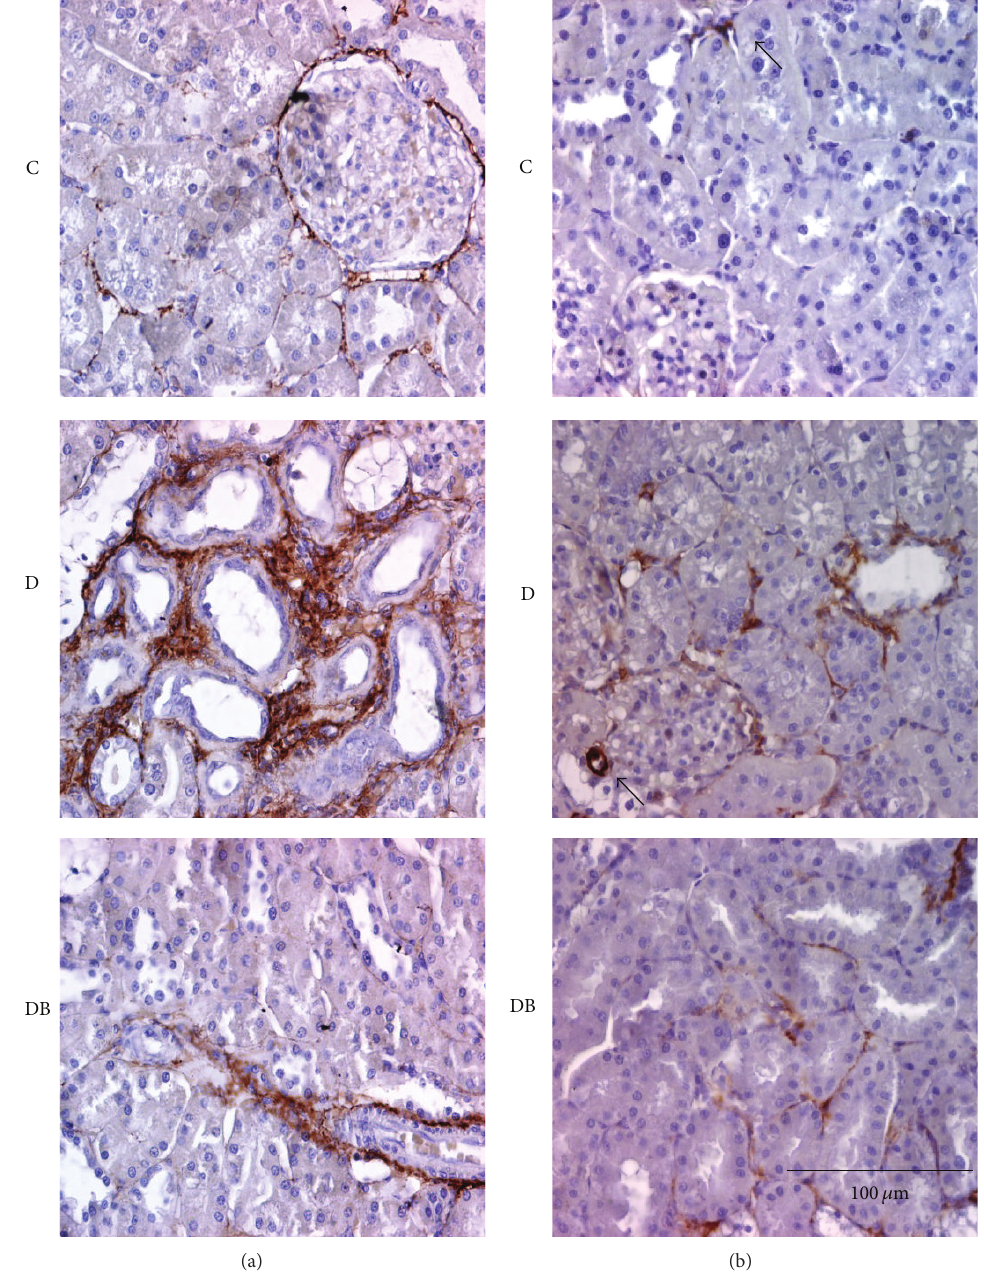
Figure 3: Boldine decreases markers of kidney damage in diabetic rats. Panels show immunohistochemistry for collagen III (a) and 𝛼 -smooth muscle actin (SMA) (b). Top panels show fields of kidney sections from control (C) rats. Central panels show fields of kidney sections from diabetic rats (D) and the bottom panels are from diabetic rats treated with 50 mg/Kg/day boldine (DB). Each picture is representative of at least 5 different animals. Arrowheads show staining in vascular